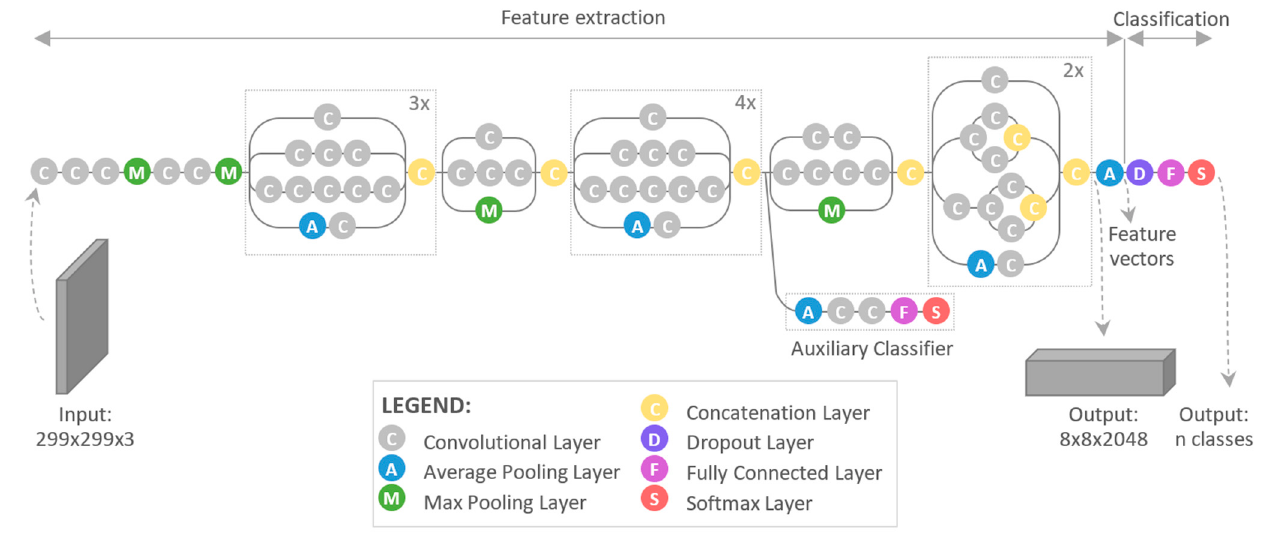
Figure 8. Inception V3 architecture.